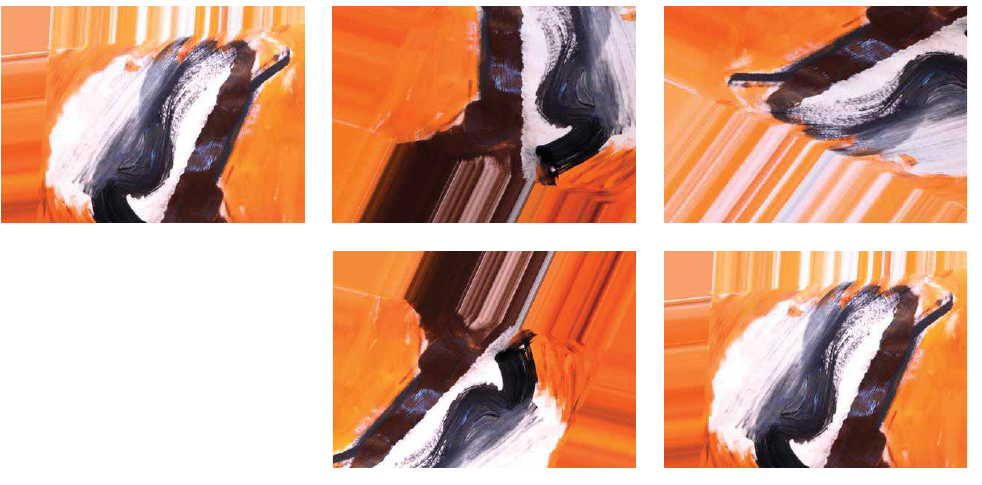
Augmentation example: top left: original image from the sample next to four augmentations of the same